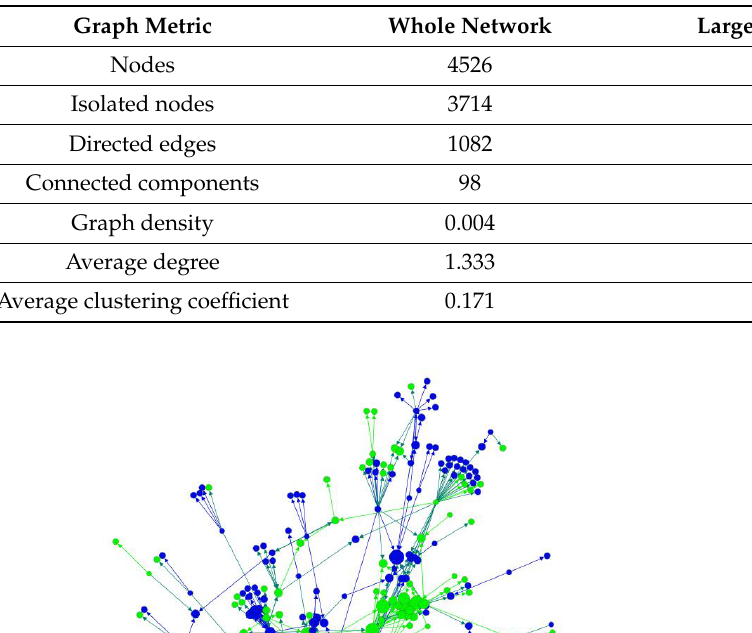
Table 2. Overall network metrics.